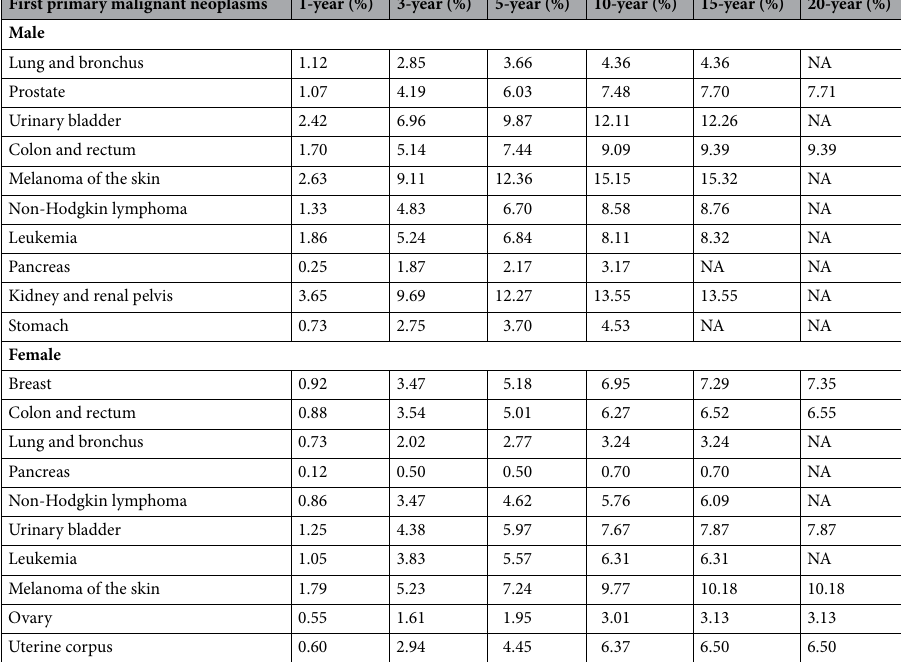
Table 1. Cumulative incidence of second primary malignant neoplasms for selected first primary malignant neoplasms, ages 85 years and older, SEER, 1975–2016. SEER, surveillance, epidemiology, and end results; NA, not